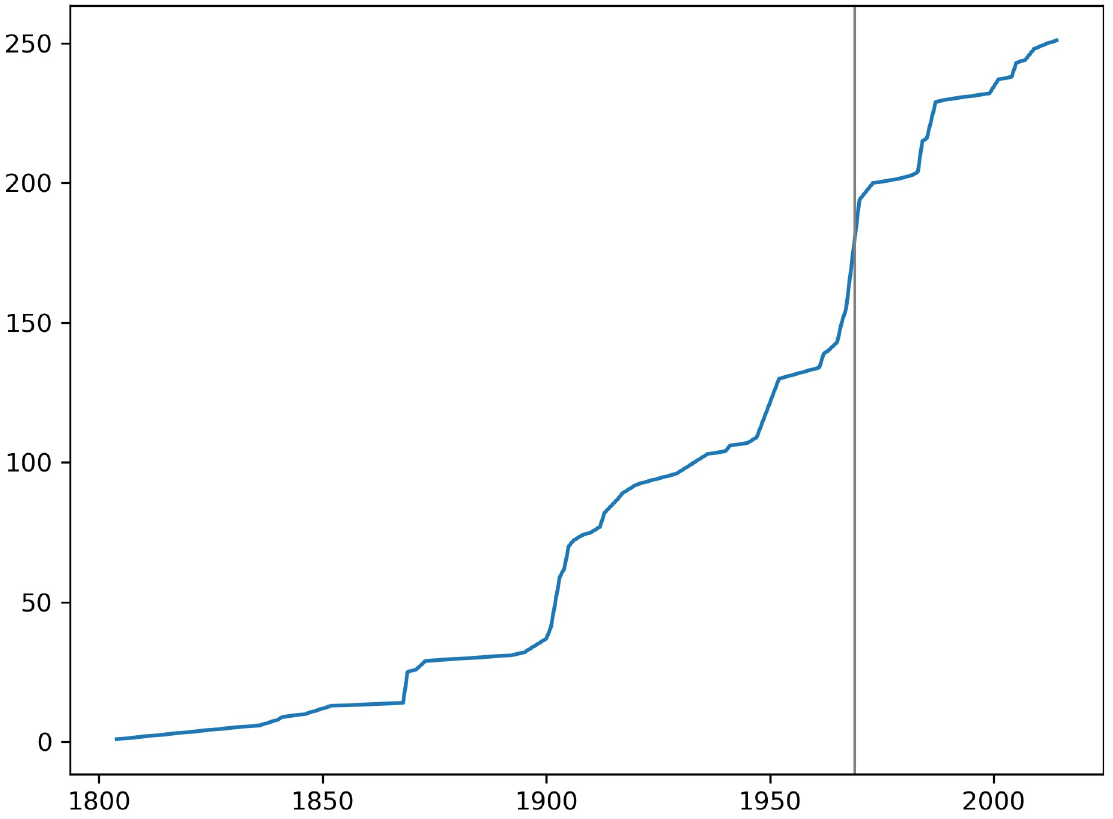
Fig 1. Cumulative number of new genera of Cryptini (Ichneumonidae, Cryptinae) described yearly, up to 2016. Vertical line shows the year before the publication of Townes [7]. Compiled from Yu et al . [8].